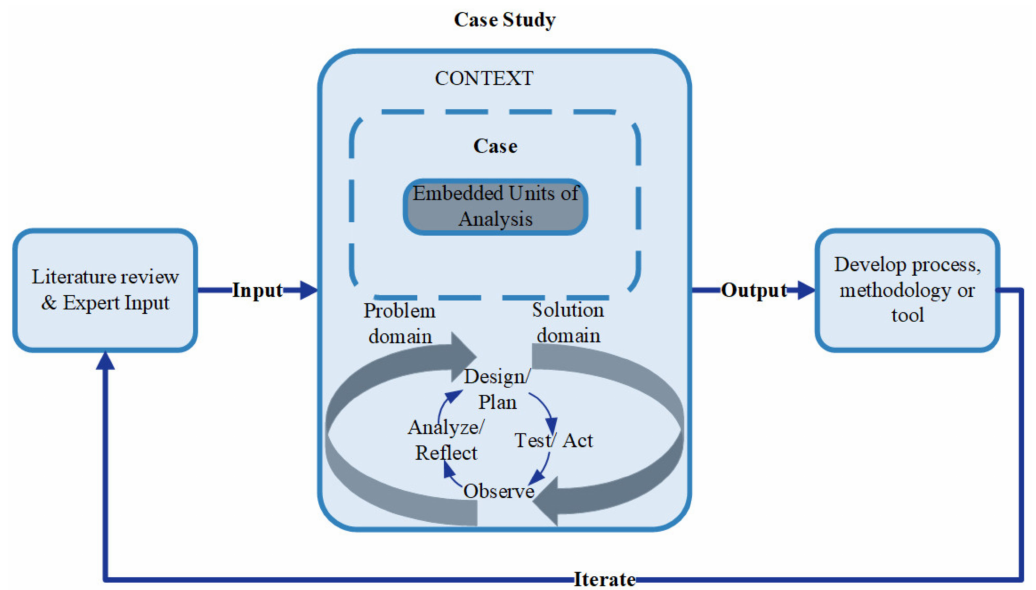
Figure 6. Case study’s research methodology.